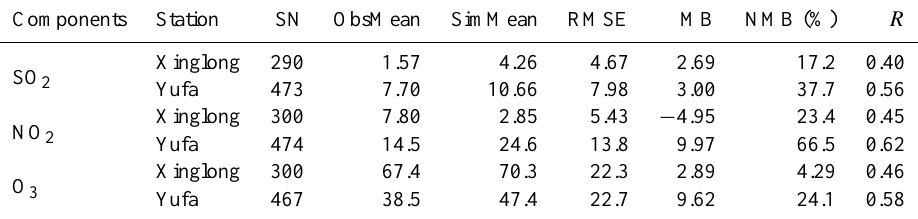
Table 5. Model evaluation at Xinglong and Yufa station. SN: number of sample, SO 2 , NO 2 and O 3 unit:ppbv; PM 10 unit: µgm − 3 . Components